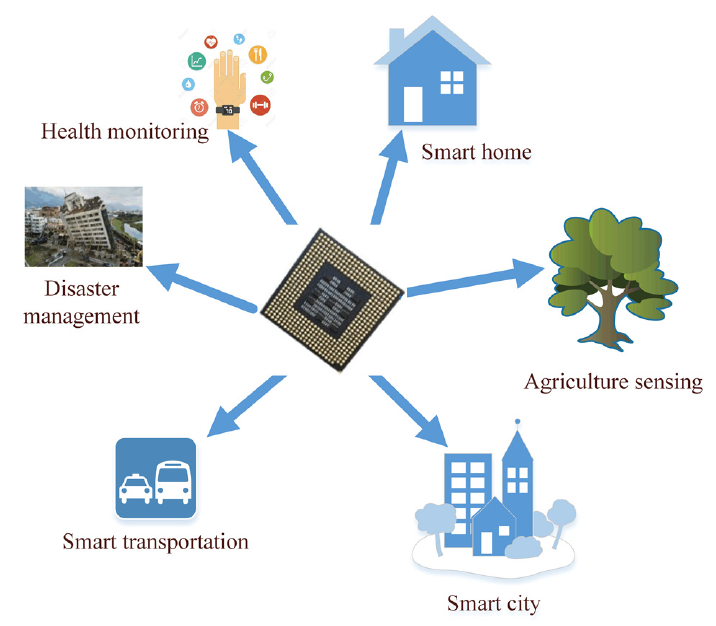
Figure 4. WSNs Figure 4. WSNs applications .